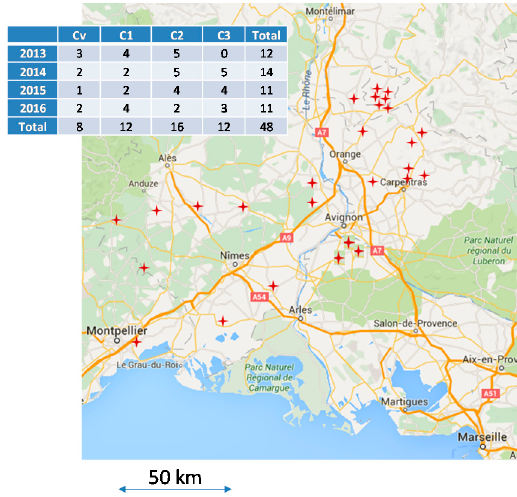
Figure 1. Experimental network and number of plots in each stage of conversion monitored each year (Cv: conventional farming; C1 to C3: first to third year of conversion to OF). Red stars on the map indicate monitored vineyard plots. Some plots were followed two consecutive years. The network covers several geographical indications of the Mediterranean wine region (Rh ô ne village wines, Ventoux wines, Chateauneuf du Pape wines, Costi è res de Nîmes and Languedoc wines, Southern Gard wines, and Southern Rh ô ne wines).